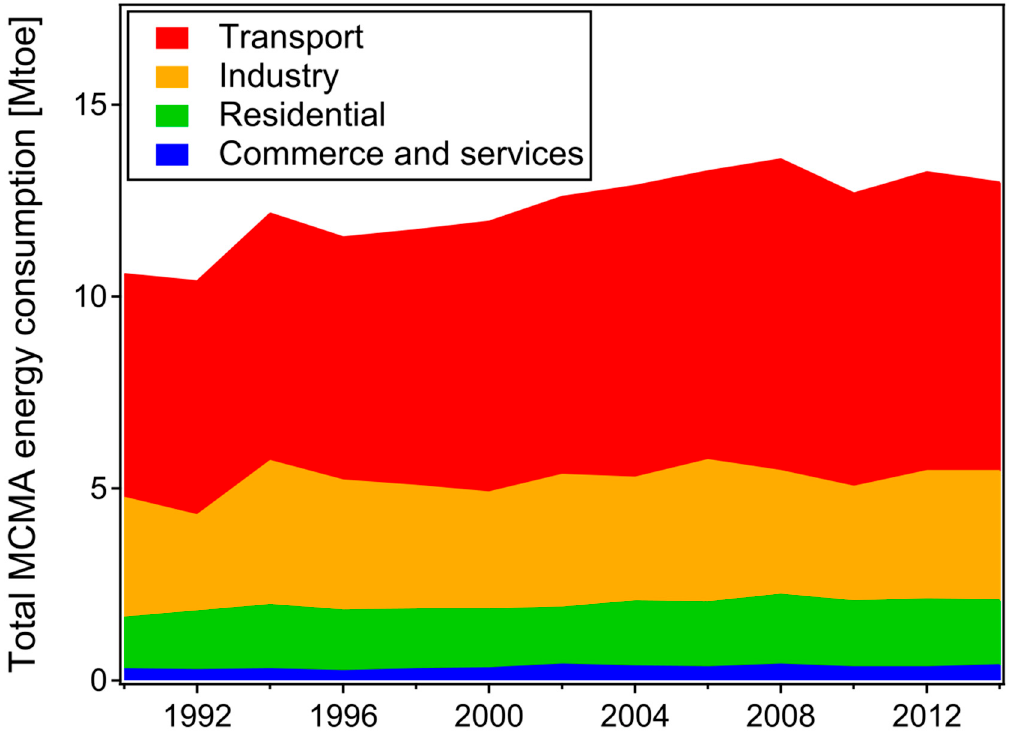
Figure 2. Trends in energy consumption for the key sectors in the Mexico City Metropolitan Area (MCMA). Source: SEDEMA [11].